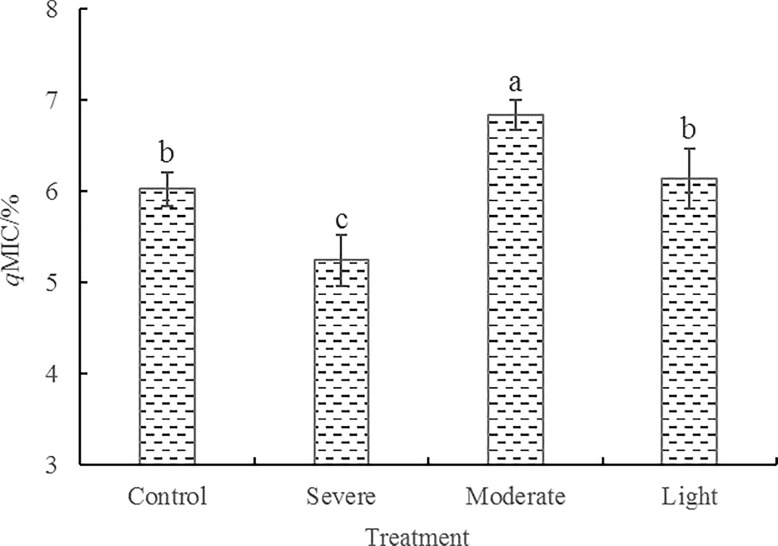
Effects of root pruning on microbial quotient (qMIC) in the rhizosphere soil of poplar.Bars are means, and error bars are standard deviations (n = 3). Different letters indicate significant differences among treatments at P<0.05 by LSD.